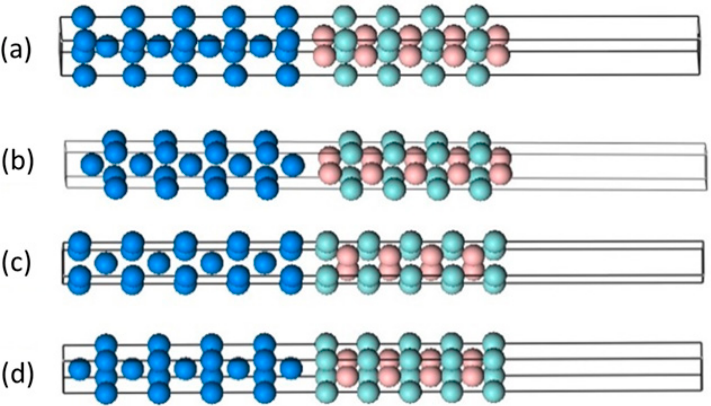
Figure 9. Four interface models of ZrB 2 /Mo: model 1 ( a ), model 2 ( b ) taking B as the terminal, model 3 ( c ) and model 4 ( d ) taking Zr as the terminal. Table 1. The interface distance of the four interface models of the ZrB 2 /Mo multilayers, the ideal interface viscosity work, and the interface energy. Stacking